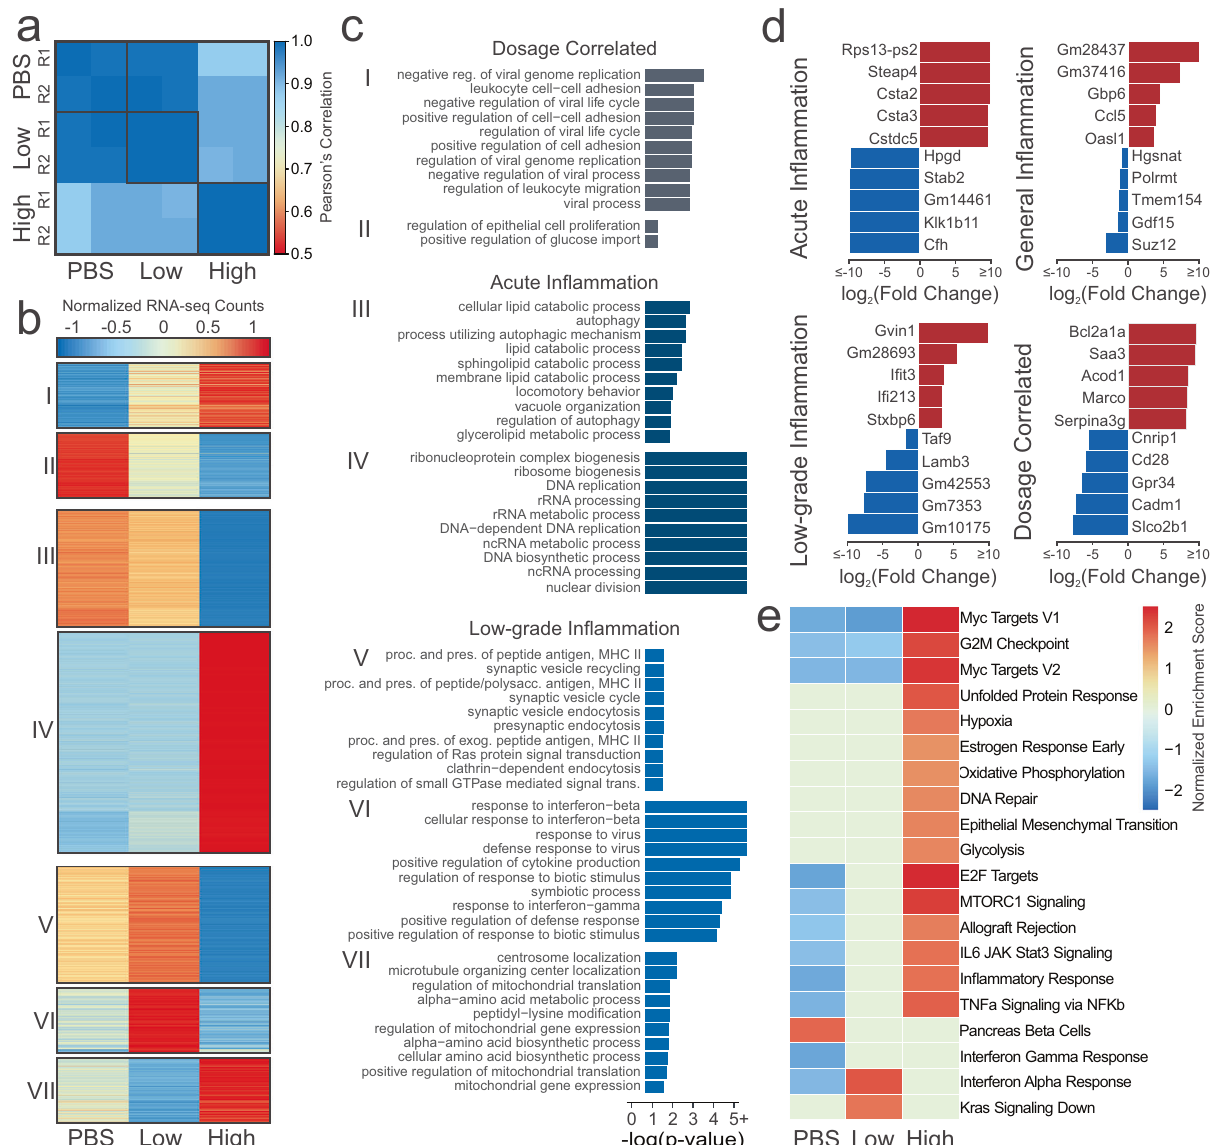
Fig. 5 Effect of LPS dosage on gene expression. a Pearson ’ s correlation of normalized RNA-seq counts at genes b Heatmap of normalized gene expression of DEGs present in more than one comparison. c Signi fi cant biological process gene ontologies for genes that are differentially expressed in more than one comparison. d Top upregulated and downregulated genes for each condition. e Gene-set enrichment analysis. Color denotes normalized expression score if that pathway was signi fi cant (FDR < 0.05) in sample vs.